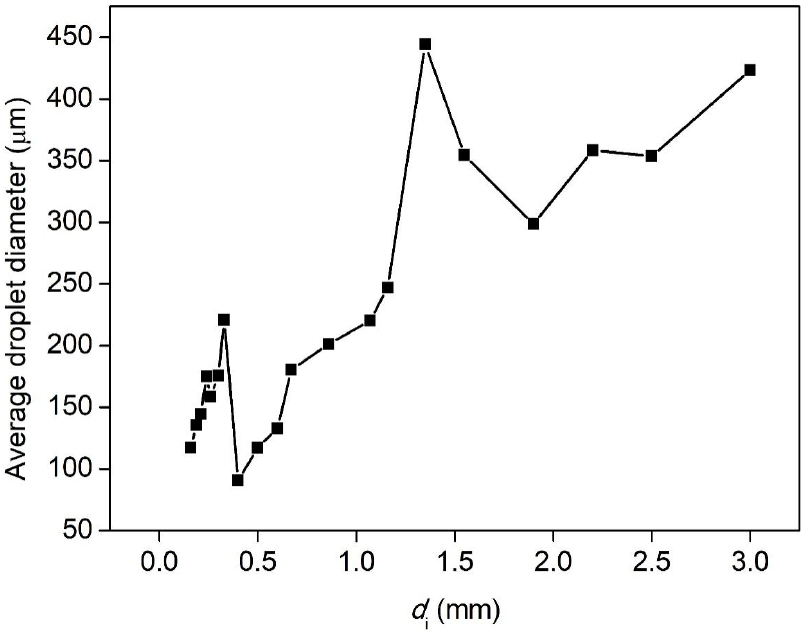
Figure 11. The average diameters of H 2 O 2 ligaments electrostatic breakup at different nozzle sizes (flow rate of 500 mL/h, voltage of 28 kV, 35 wt. % concentration). (flow rate of 500 mL/h, voltage of 28 kV, 35 wt. %